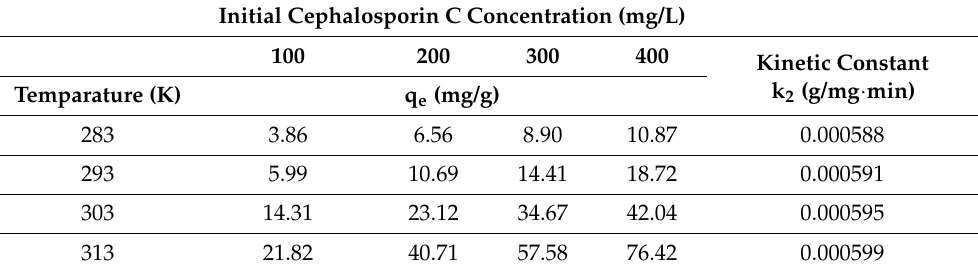
Table 5. Temperature effect on the amount of CPC loaded onto the AOS (q e ) at different CPC initial concentrations and on the rate constant of the pseudo-second-order adsorption kinetic